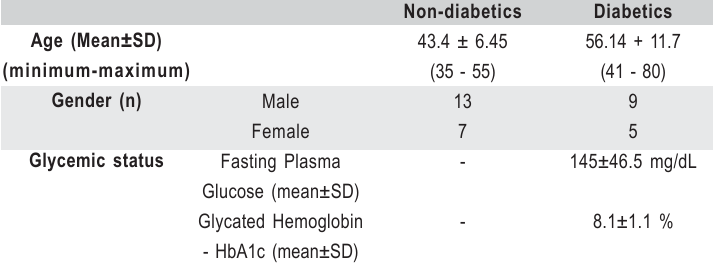
Table 1. Demographic characteristics of subjects.